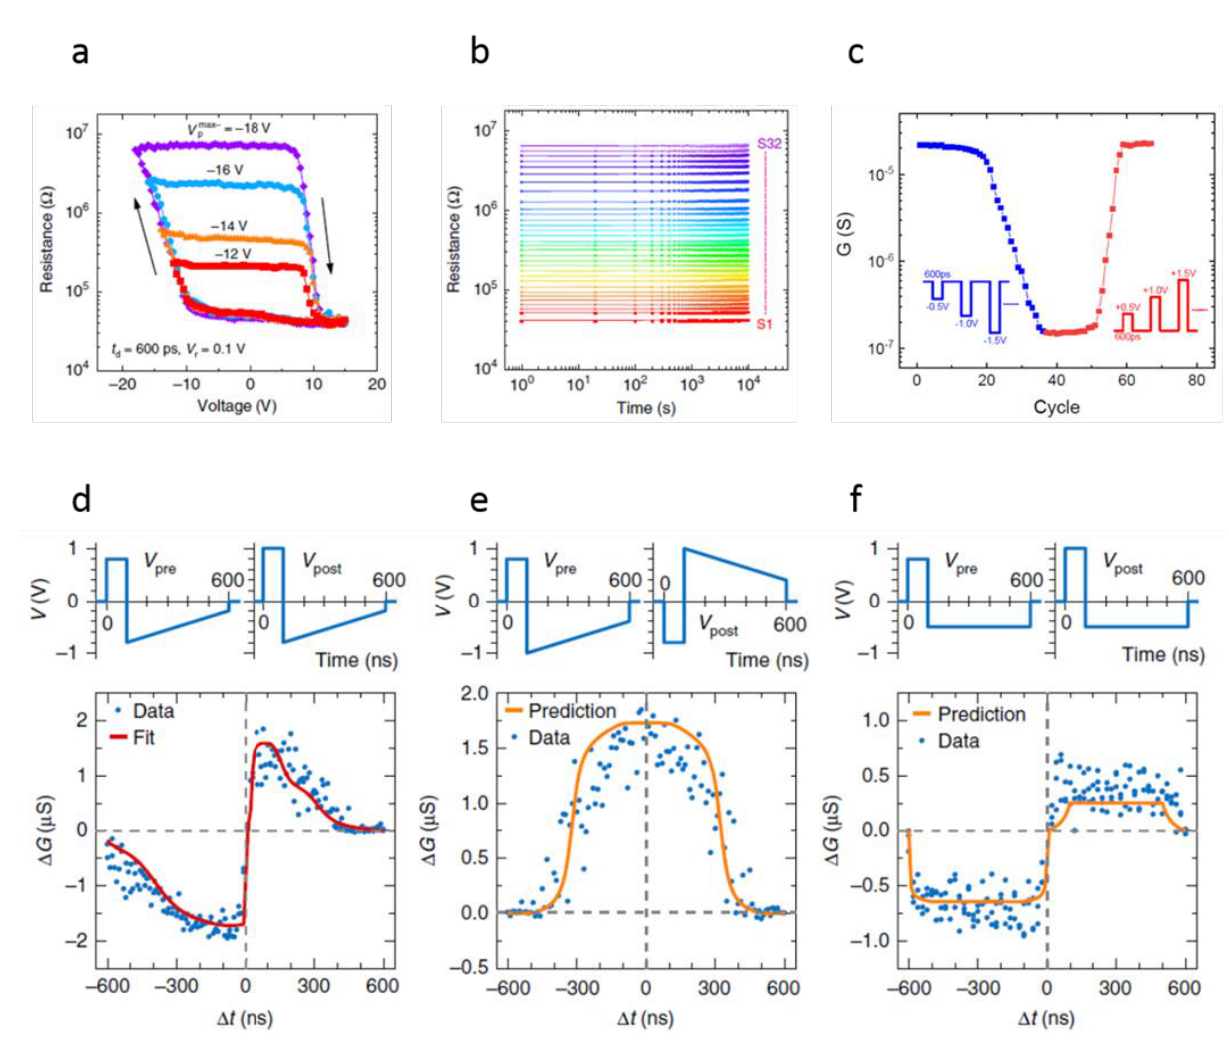
Figure 8. ( a ) Resistive switching with gradual change in Ag/BaTiO 3 (~ 2.4 nm)/Nb:SrTiO 3 ferroelectric tunnel junction under consecutive pulses (writing voltage = – 18, – 16, – 14, and – 12 V, fixed pulse duration = 600 ps). ( b ) Retention characteristics of the Ag/BaTiO 3 (~ 2.4 nm)/Nb:SrTiO 3 ferroelectric tunnel junction. ( c ) Analog switching behaviors of an ultra-thin ferroelectric-film-based synaptic device (Ag/BaTiO 3 (~ 2.4 nm)/Nb:SrTiO 3 ) under consecutive non-identical pulses with a sub-nanosecond (600 ps) duration. Reprinted/adapted with permission from Reference [47]. 2020, Springer Nature. ( d – f ) STDP curves of different forms in an ultra-thin ferroelectric-film-based synaptic device (Co/BFO/CCMO). The top and bottom panels show presynaptic and postsynaptic spikes and the change in conductance, respectively. Reprinted/adapted with permission from Reference [45]. 2017, Springer Nature.